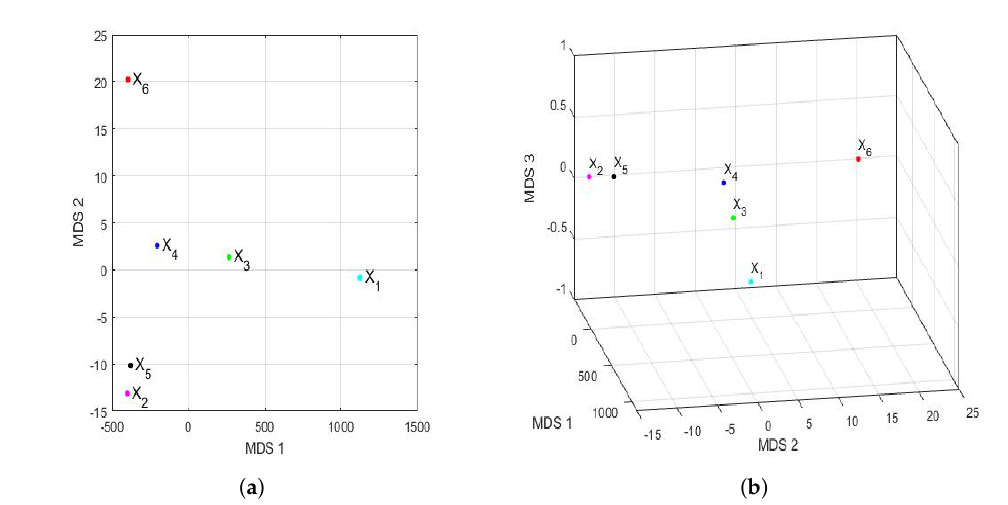
Figure 16. Location of the feature vectors of the variables with respect to the first two and three principal coordinates: X 1 (2015), . . ., X 6 (2020). ( a ) Feature vectors: first 2 principal coordinates. ( b ) Feature vectors: first 3 principal